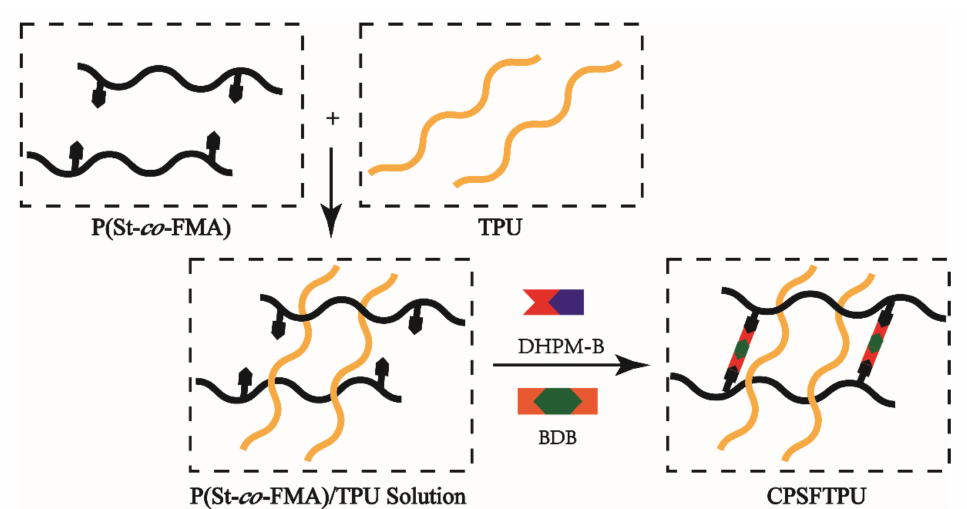
Figure 2. Preparation of semi IPNs of